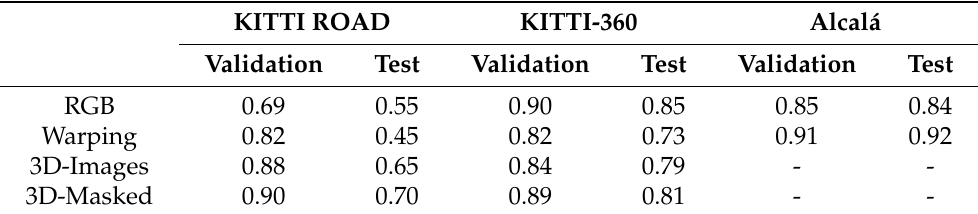
Table 6. Multi-frame paradigm